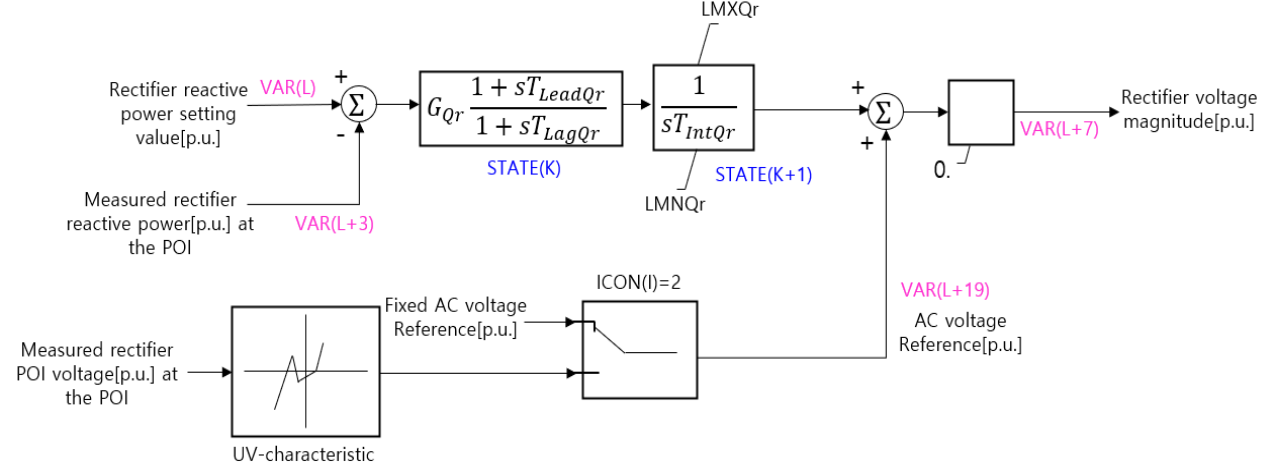
Figure A5. HVDCPLU1 model of PSS/E [15,16].